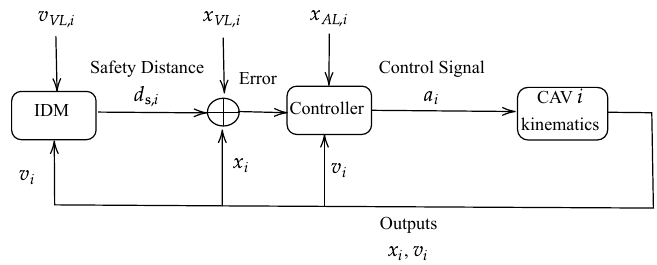
Figure 3. Methodology block